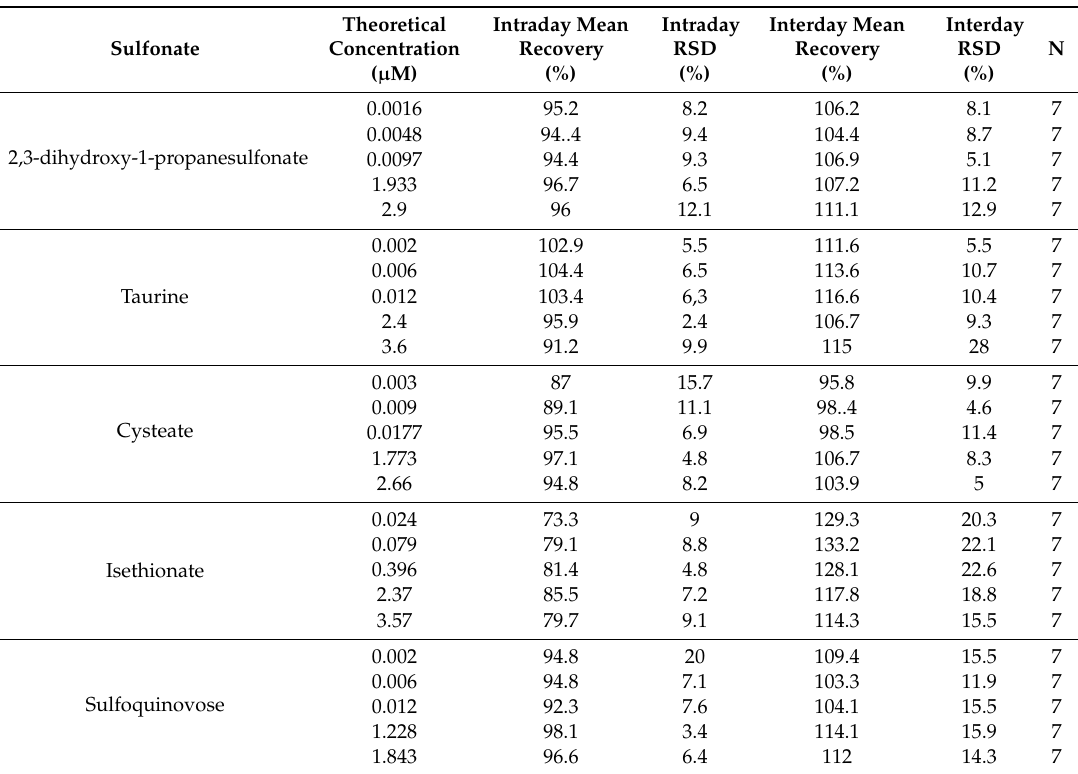
Table 3. Mean recovery and intraday and interday relative standard deviation of sulfonates spiked into fecal supernatants and diluted 1:10,000. (RSD relative standard deviation)